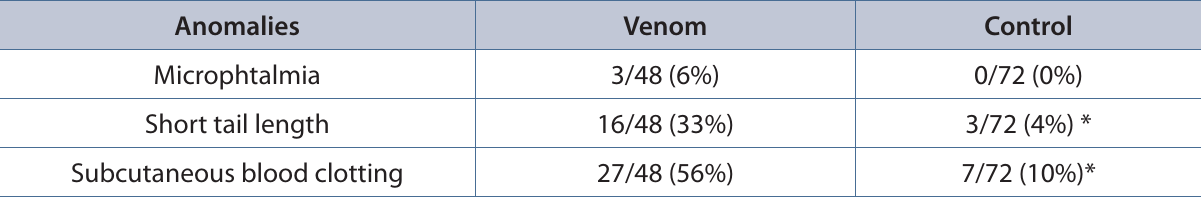
Table 2. External fetal anomalies observed in offspring of rats repetitively exposed to scorpion venom from the 7 th to the 13 th day of gestation